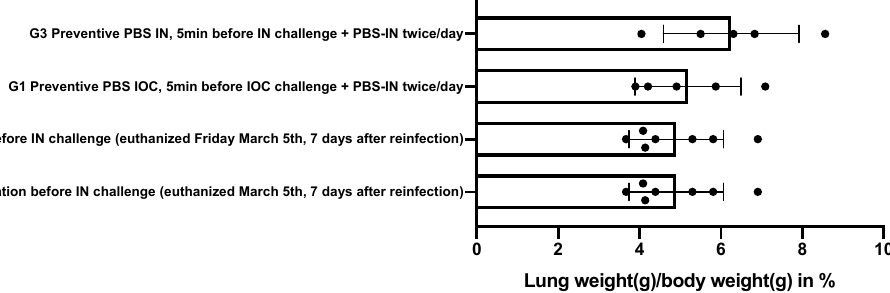
Figure 4. Lung weight of the right lung [g] relative to the whole body weight [g] in the different groups.